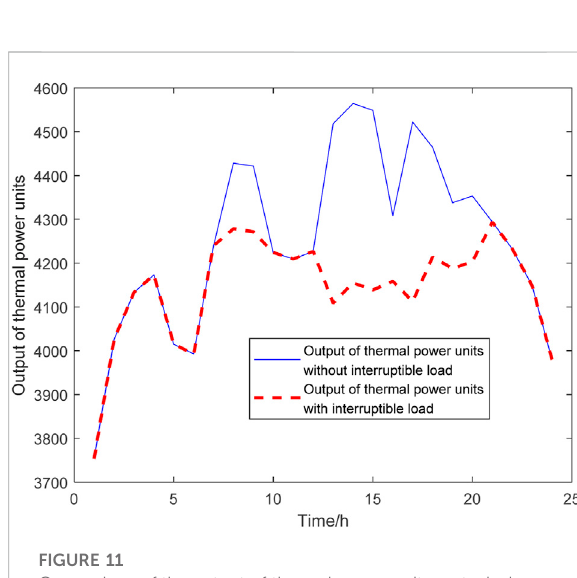
FIGURE 9 Comparison of the output of thermal power units on typical day 1 with two million kW interruptible loads.